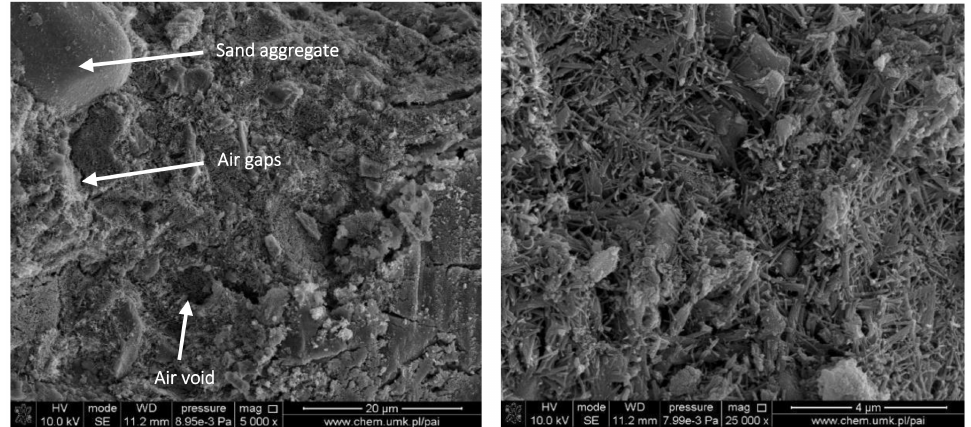
Figure 6. SEM microstructure of reference